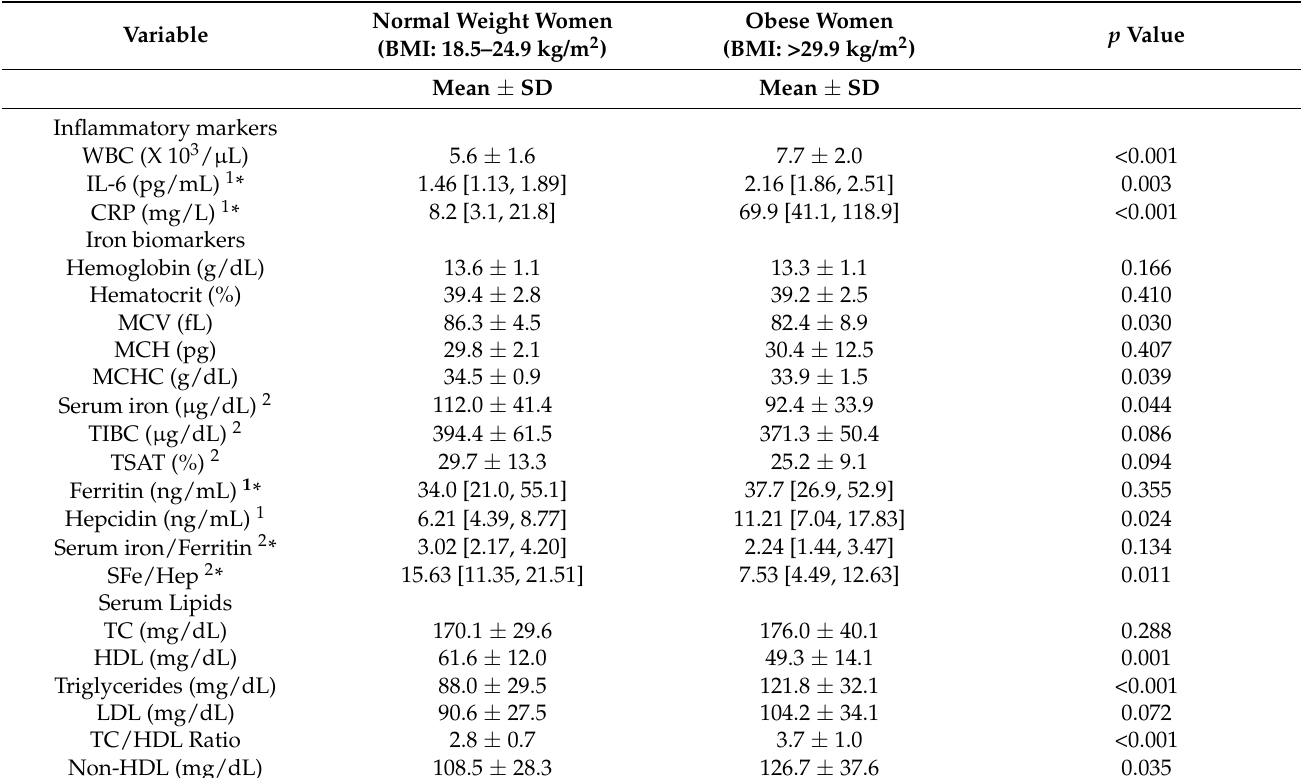
Table 2. Inflammatory markers, iron status, and serum lipid concentrations in obese ( n = 25) and normal weight healthy young women ( n =